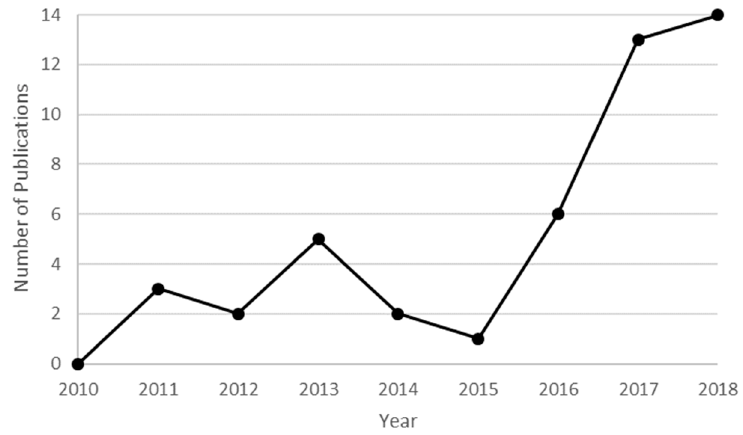
Figure 2. The evolution of published studies in scientific journals regarding machine learning techniques used in atmospheric sciences.